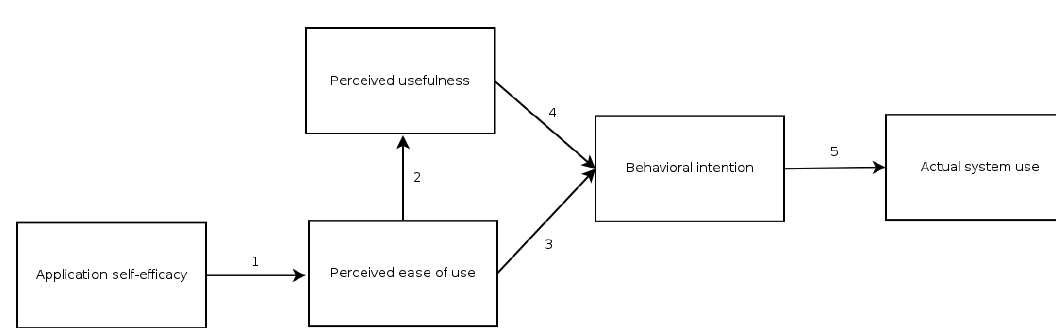
Figure 3 . The technology acceptance model with application self-efficacy variable. (Developed from Davis & Venkatesh, 1996 and Yi & Hwang, 2003)